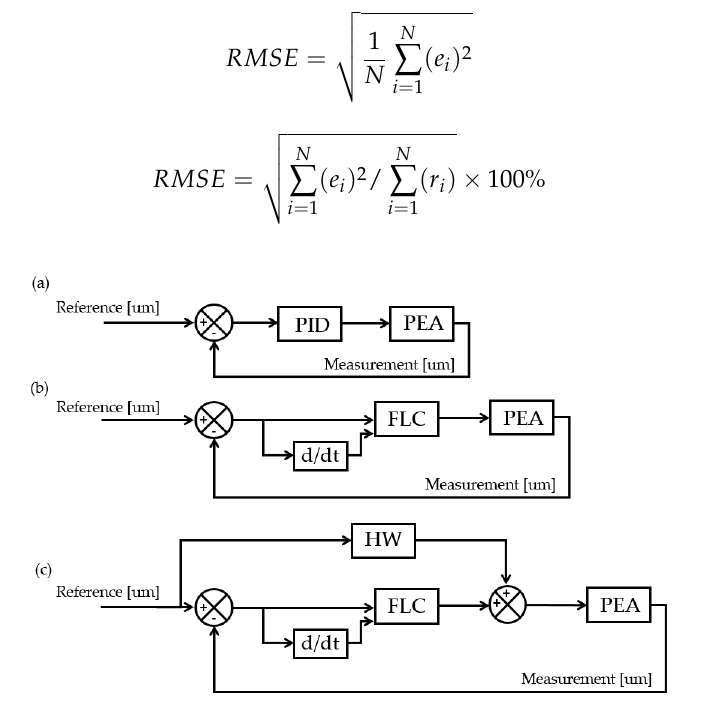
Figure 3. Control architectures used during the experiments. ( a ): Feedback with proportional-integral- derivative (PID); ( b ): Feedback with fuzzy logic control (FLC); and, ( c ): Feedback with FLC and Hammerstein–Wiener mapping as a feedforward (HW-FF).